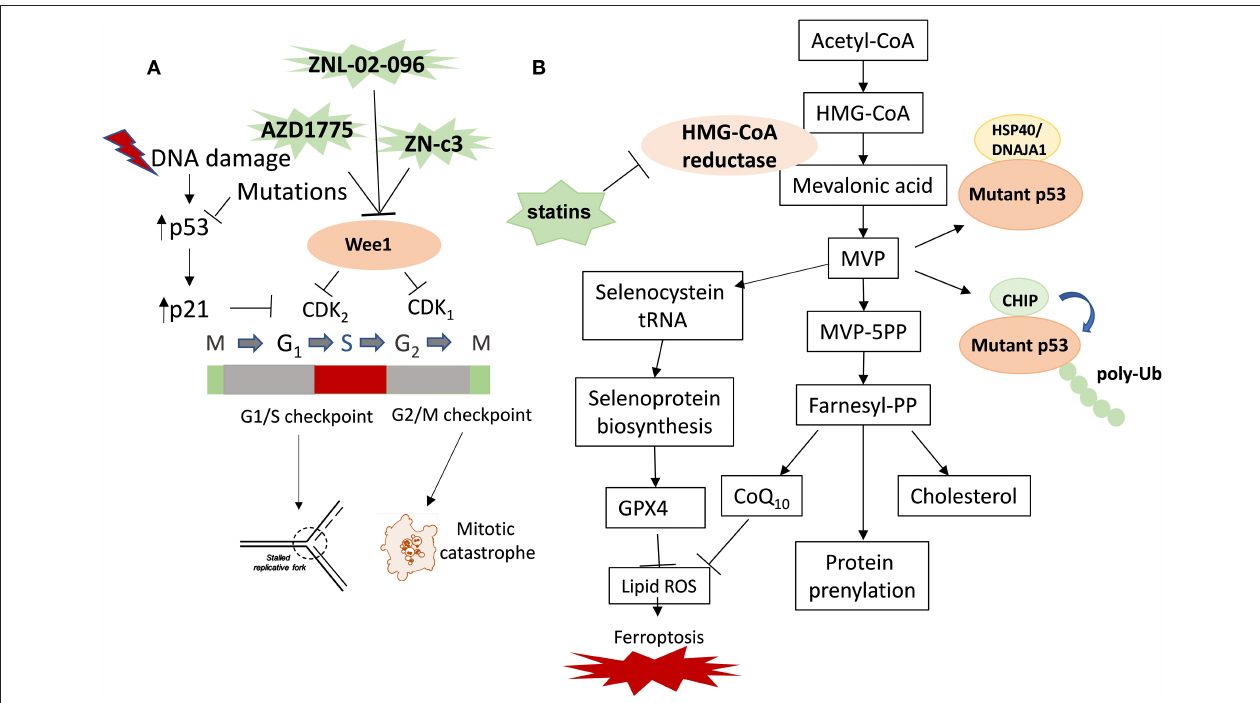
FIGURE 1 | Therapeutic strategies targeting Wee1 and the mevalonate pathway in cancer with p53 mutations. The therapeutic strategies targeting mutp53 in cancer include targeting mutp53 directly or indirectly. The indirect strategies include inhibition of the critical downstream pathways of mutp53 and the direct strategies include inducing mutp53 degradation. (A) Wee1 inhibitor induces replication catastrophe and mitotic catastrophe in cancer cells with p53 mutations. (B) Statins inhibit mevalonate pathway and promote degradation of mutp53 and induce ferroptosis. Mevalonate-5-phosphate (MVP) promotes mutp53 stabilization by increasing the interaction between mutp53 and KSP40/DNAJA1 and inhibiting CHIP-mediated ubiquitination and proteasomal degradation of mutp53. Inhibition of the mevalonate pathway with statins represents a novel therapeutic strategy of targeting cancers with mutp53 by inducing mutp53 degradation, inhibiting prenylation of oncogenes and cholesterol synthesis, as well as inducing ferroptosis by inhibiting the biosynthesis of GPX4 and CoQ10.